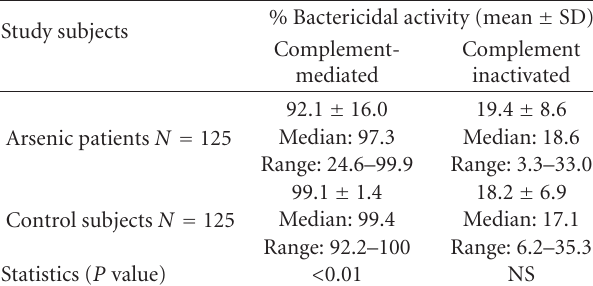
Table 1: Complement-mediated and complement-inactivated bac- tericidal activities in the serum of arsenic patients and control subjects.